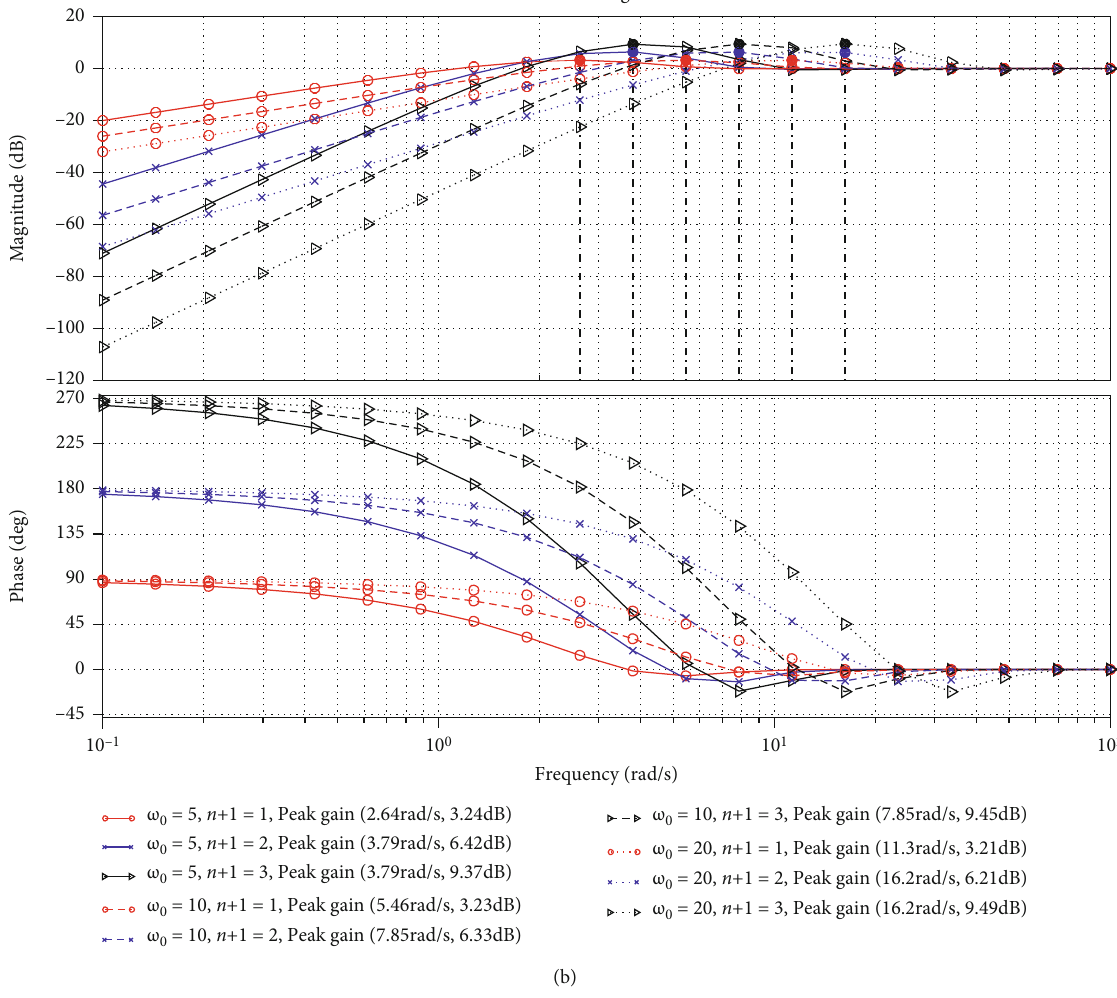
Figure 4: High-order LESO disturbance suppression frequency response: (a) system order is 3; (b) system order is